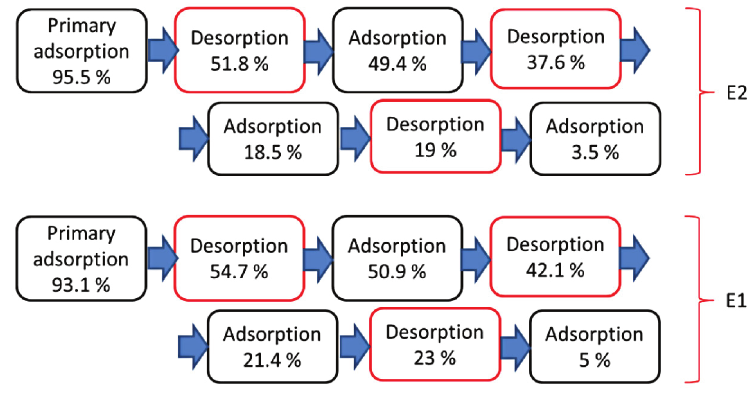
Fig. 8 – Desorption/adsorption modeling of E2 and E1 hormones on rice husk